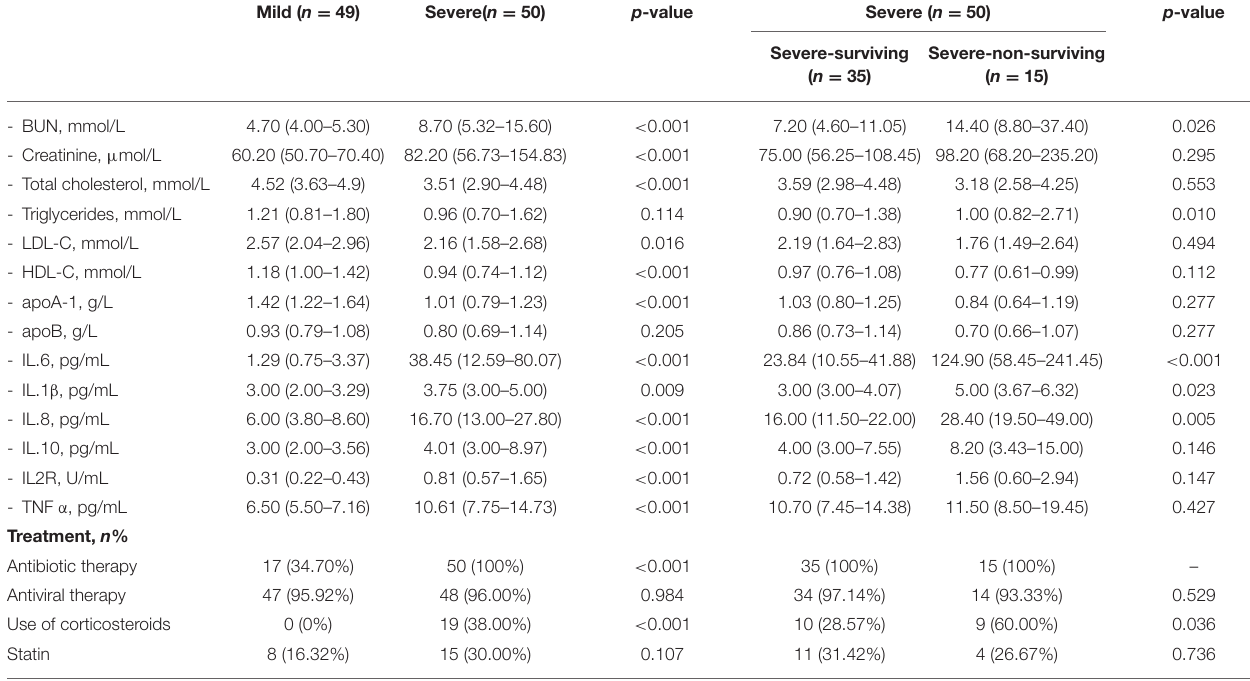
Frontiers in Cardiovascular Medicine |